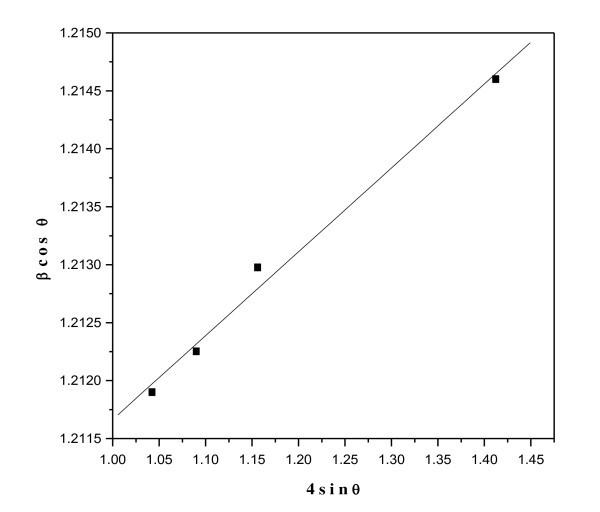
Strain graph of the nanoparticles of Ni0.2Cd0.3Fe2.5 - xAlxO4 (0.0 ≤ x ≤ 0.5) ferrite nanoparticles.